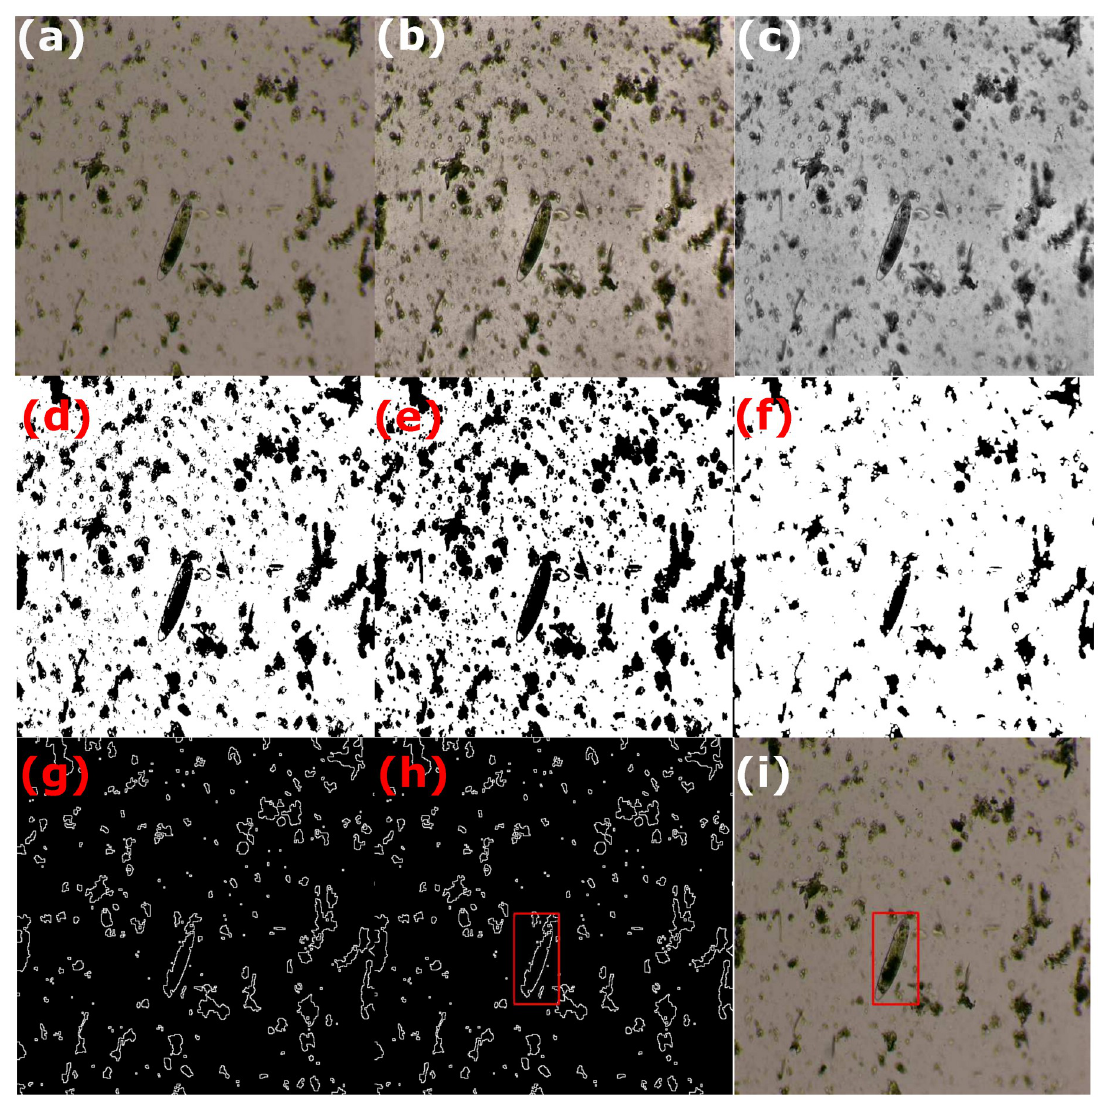
Fig 4. Parasite detection using image processing techniques: (a) original image; (b) image contrast enhancement using CLAHE; (c) color to grayscale image conversion; (d) image binarization using the OTSU method; (e) erode-based morphological operation; (f) dilate-based morphological operation; (g) morphological gradient operation; (h) the largest areas are strong candidate regions to contain the region of interest (the image depicts only the largest one), and (i) plotting the region of interest in the original image.